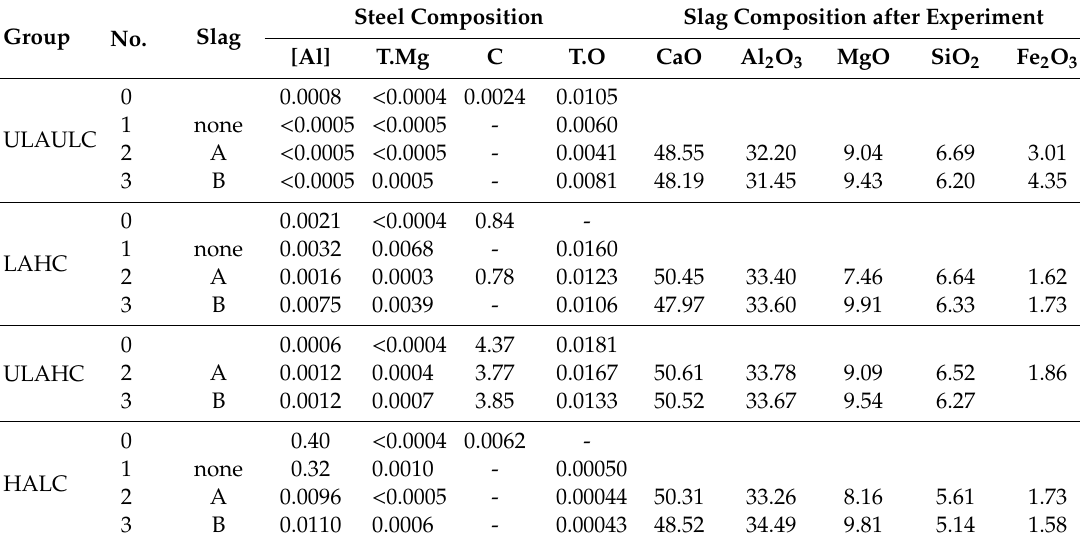
Table 4. Steel and slag composition before and after quasi-equilibrium experiments (%). Steel Composition Slag Composition after Group No. Slag